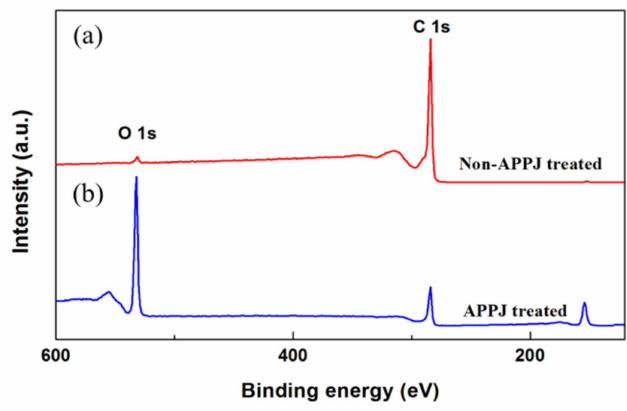
Figure 4. XPS survey spectra of ( a ) non-modified and ( b ) APPJ-modified graphite sheets.